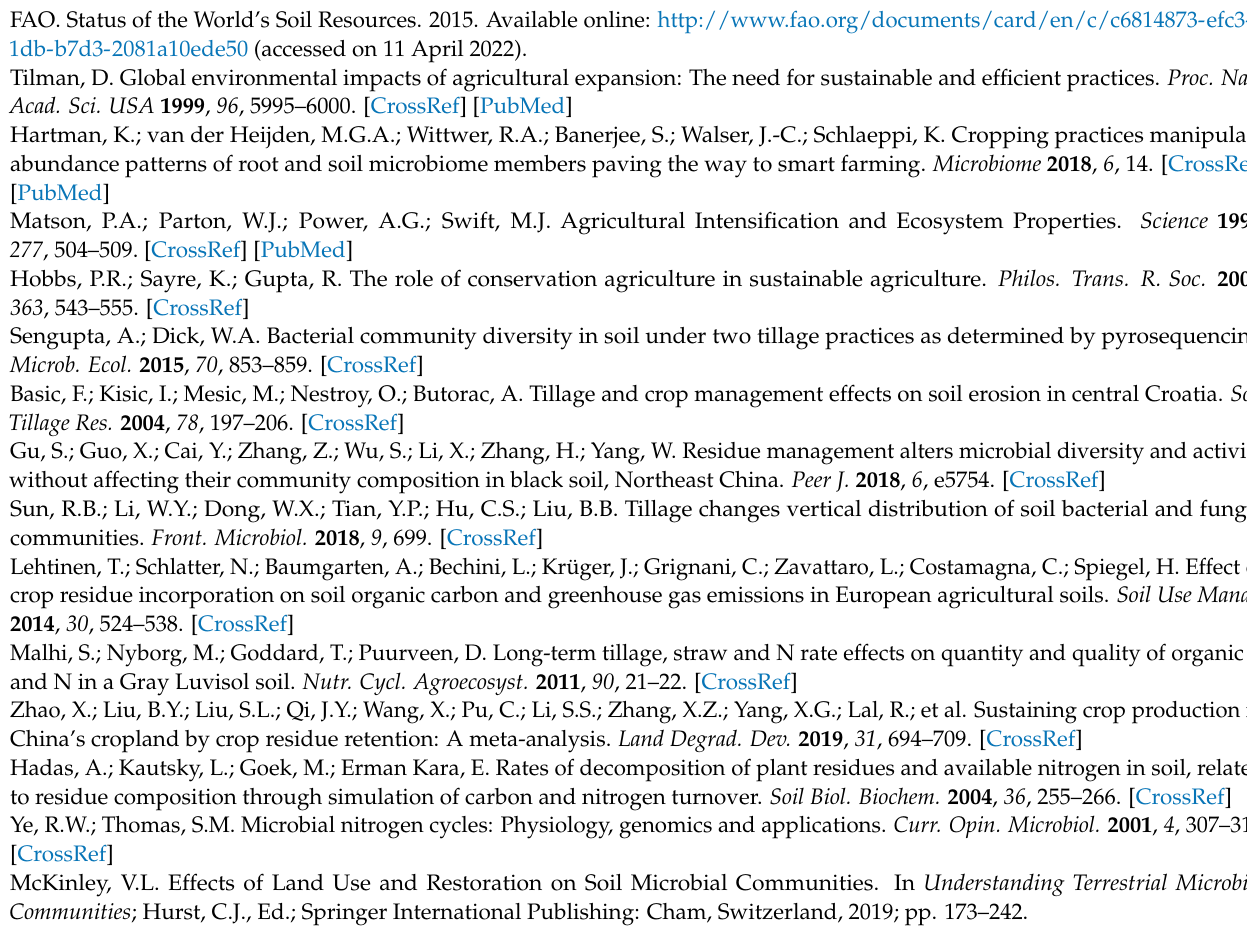
Table S9: Results of stepwise multiple-regression models using bacterial and fungal OUT richness as response variables. Figure S1: The relative abundance of the dominant bacterial (A) and fungal (B) phyla among treatments. Figure S2: Co-occurrence networks of combined soil bacterial-fungal communities among treatments (A), proportion of bacteria-bacteria (B-B) links, fungi-bacteria (F-B) links, fungifungi (F-F) links, proportion of bacterial nodes and fungal nodes among treatments. Author Contributions: Conceptualization, W.Y. and X.Z.; methodology, W.Y.; software, Y.G.; valida- tion, Y.G. and B.X.; formal analysis, Y.G. and B.X.; investigation, Y.G. and B.X.; resources, W.Y.; data curation, W.Y.; writing—original draft preparation, Y.G. and B.X.; writing—review and editing, W.Y. and X.Z.; visualization, Y.G.; supervision, W.Y.; project administration, X.Z.; funding acquisition, X.Z. All authors have read and agreed to the published version of the manuscript. Funding: This research was funded by the National Natural Science Foundation of China (grant number: